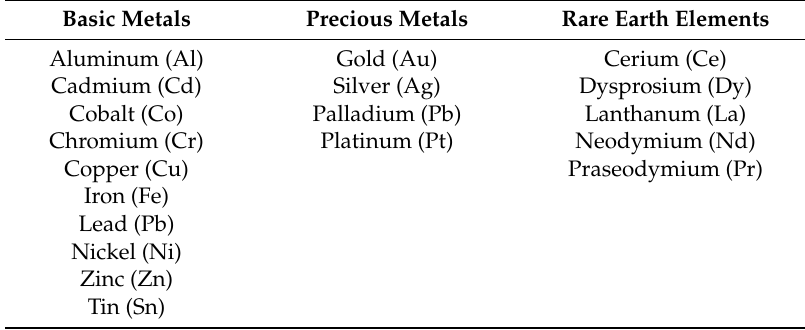
Table 4. Selected elements for chemical analysis of WEEE samples.